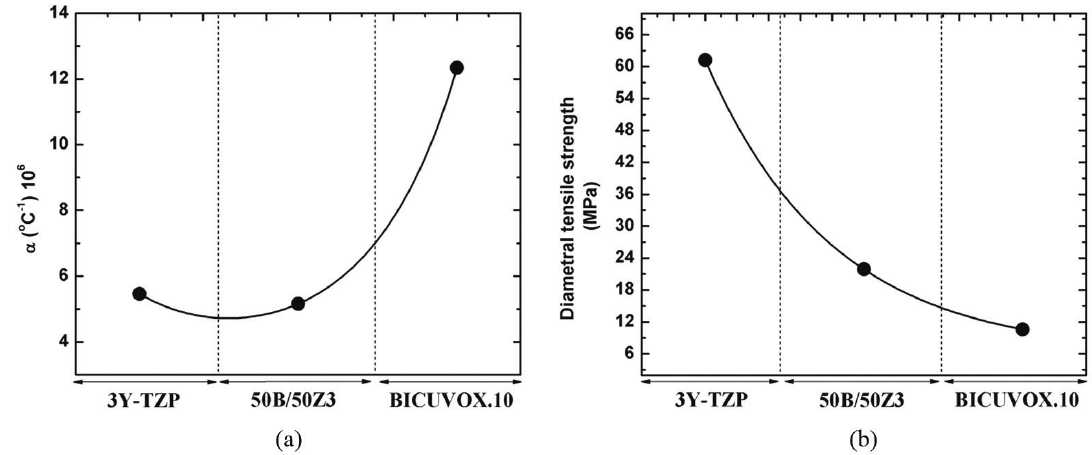
Figure 4. (a) Coefficients of linear thermal expansion for 3Y-TZP, BICUVOX.10 and 50B/50Z3, which represent the reaction zone. (b) Diametral tensile strength for 3Y-TZP, BICUVOX.10 and 50B/50Z3. Diametral tensile strength graph exhibits only the mean